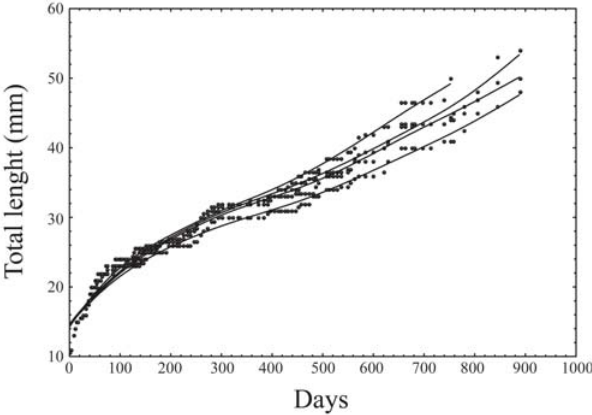
Fig. 3. Size (total length, in mm) versus age (in days) in seven specimens (respectively a to g) of Ancistrus cryptophthalmus from Passa Três Cave born in laboratory in March